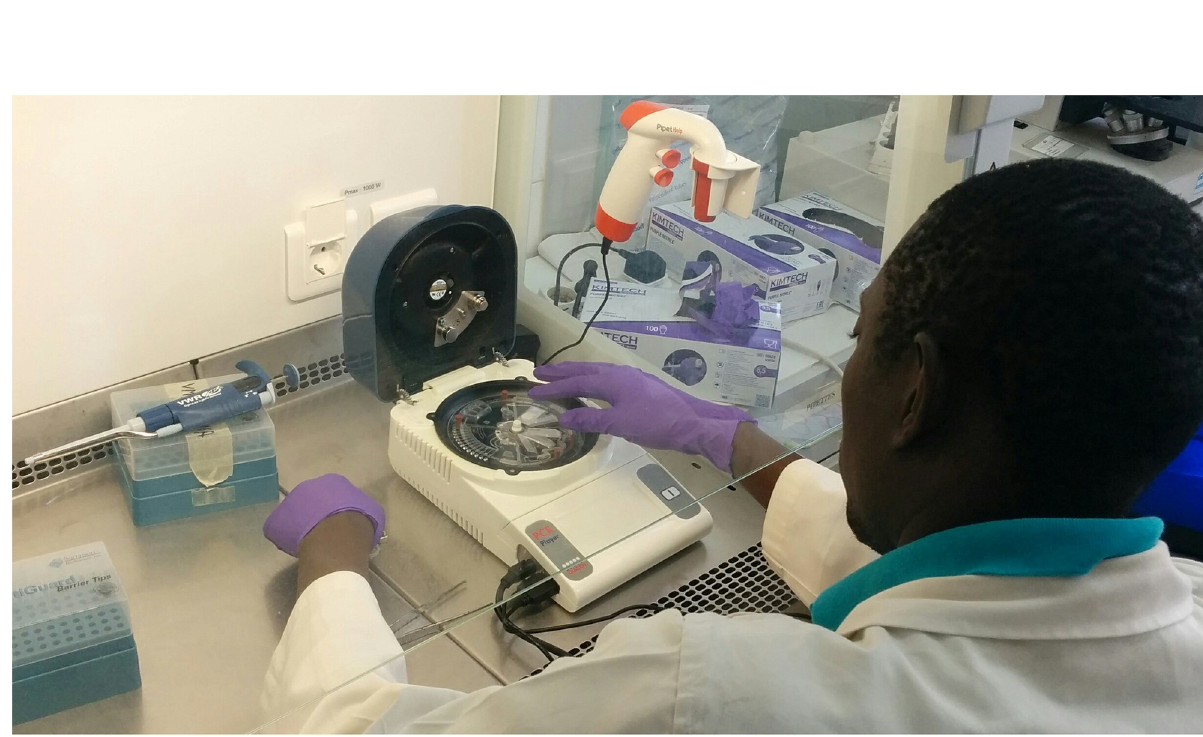
Fig 2. Photograph of the FeverDisk processing device. Dr. Cheikh Fall, co-author from the Institut Pasteur de Dakar, prepares a FeverDisk for measurement.